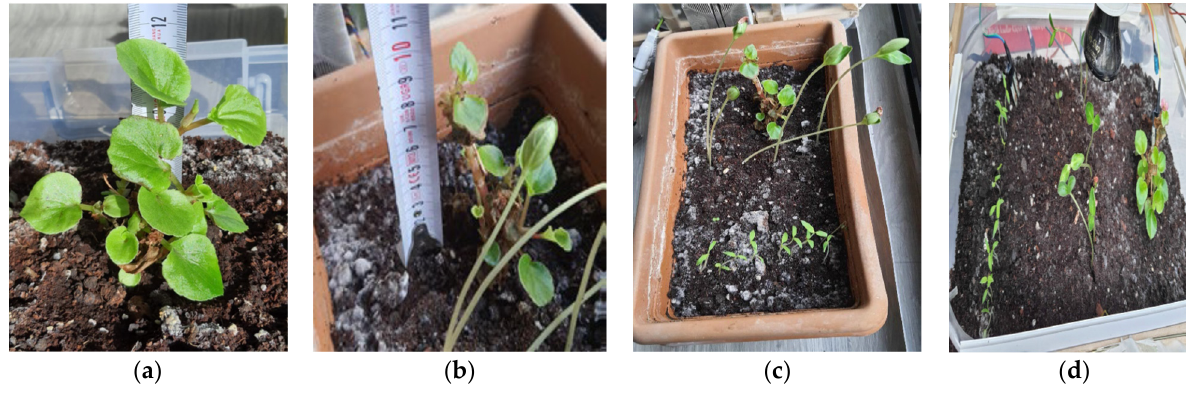
Figure 16. Development graph of pepper seedling in smart greenhouse and pot.